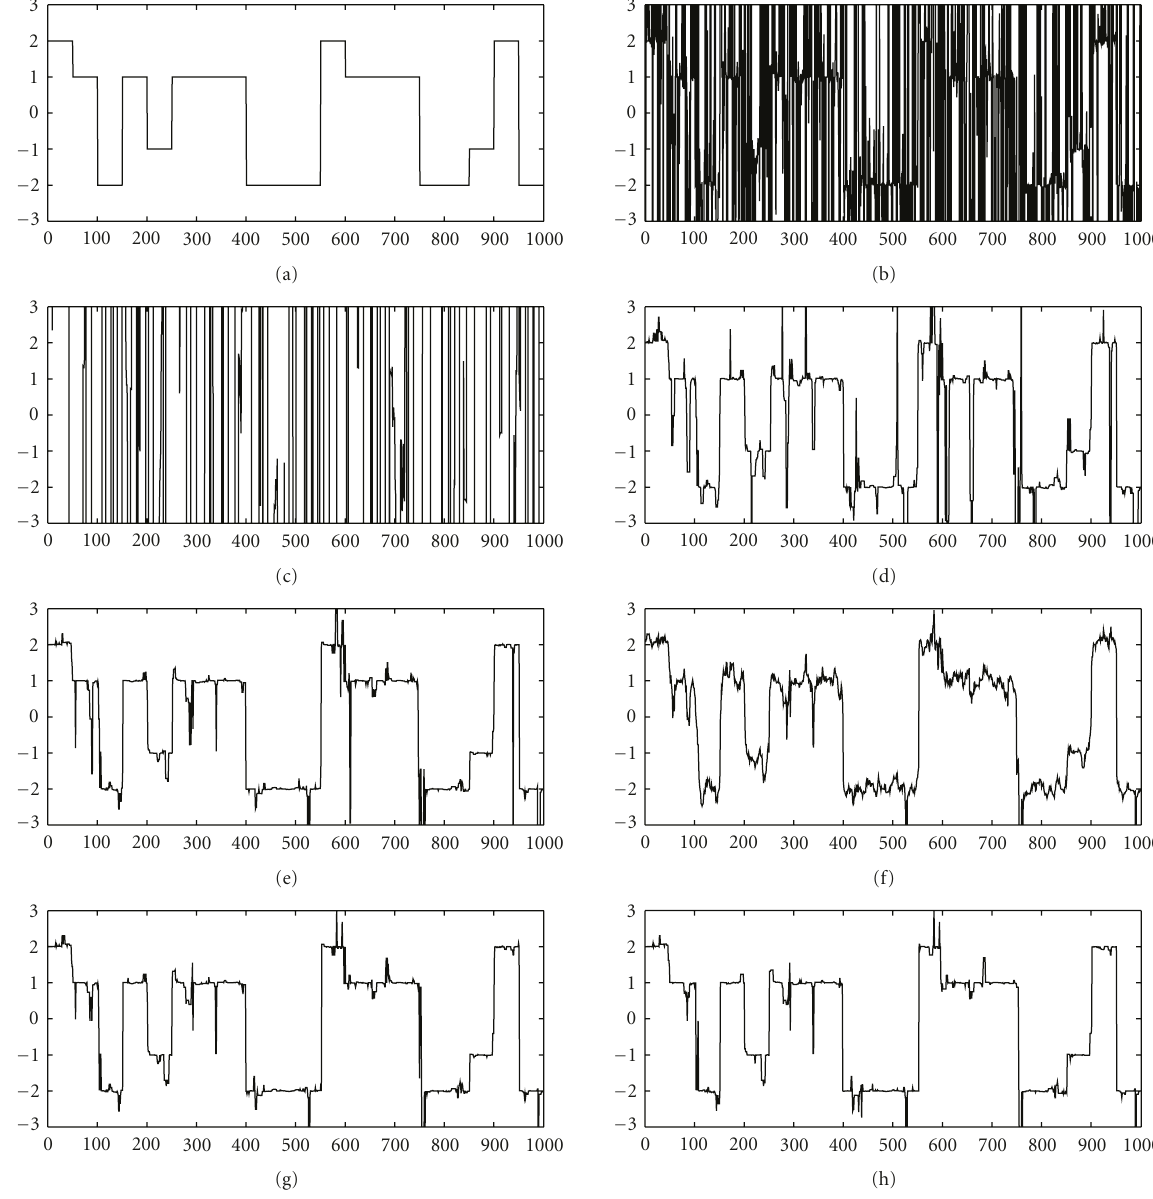
Figure 6: Power line communication enhancement. (a) Transmitted signal, (b) Received signal corrupted by α -stable noise α = 0 . 4. Filtering results with: (c) Mean, (d) Median, (e) FLOM P = . 25, (f) Myriad, (g) Meridian, (h)